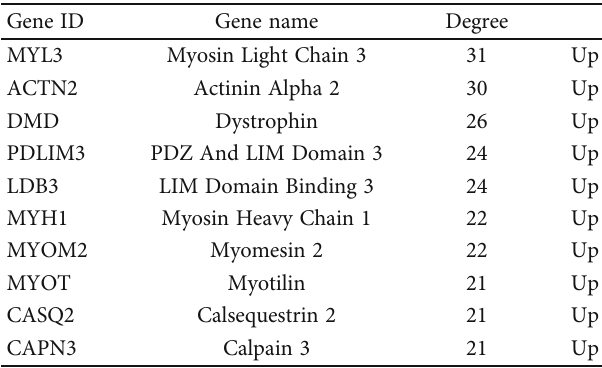
Figure 5: A DEG PPI network constructed using the STRING database. Table 2: Degree of top 10 genes in top